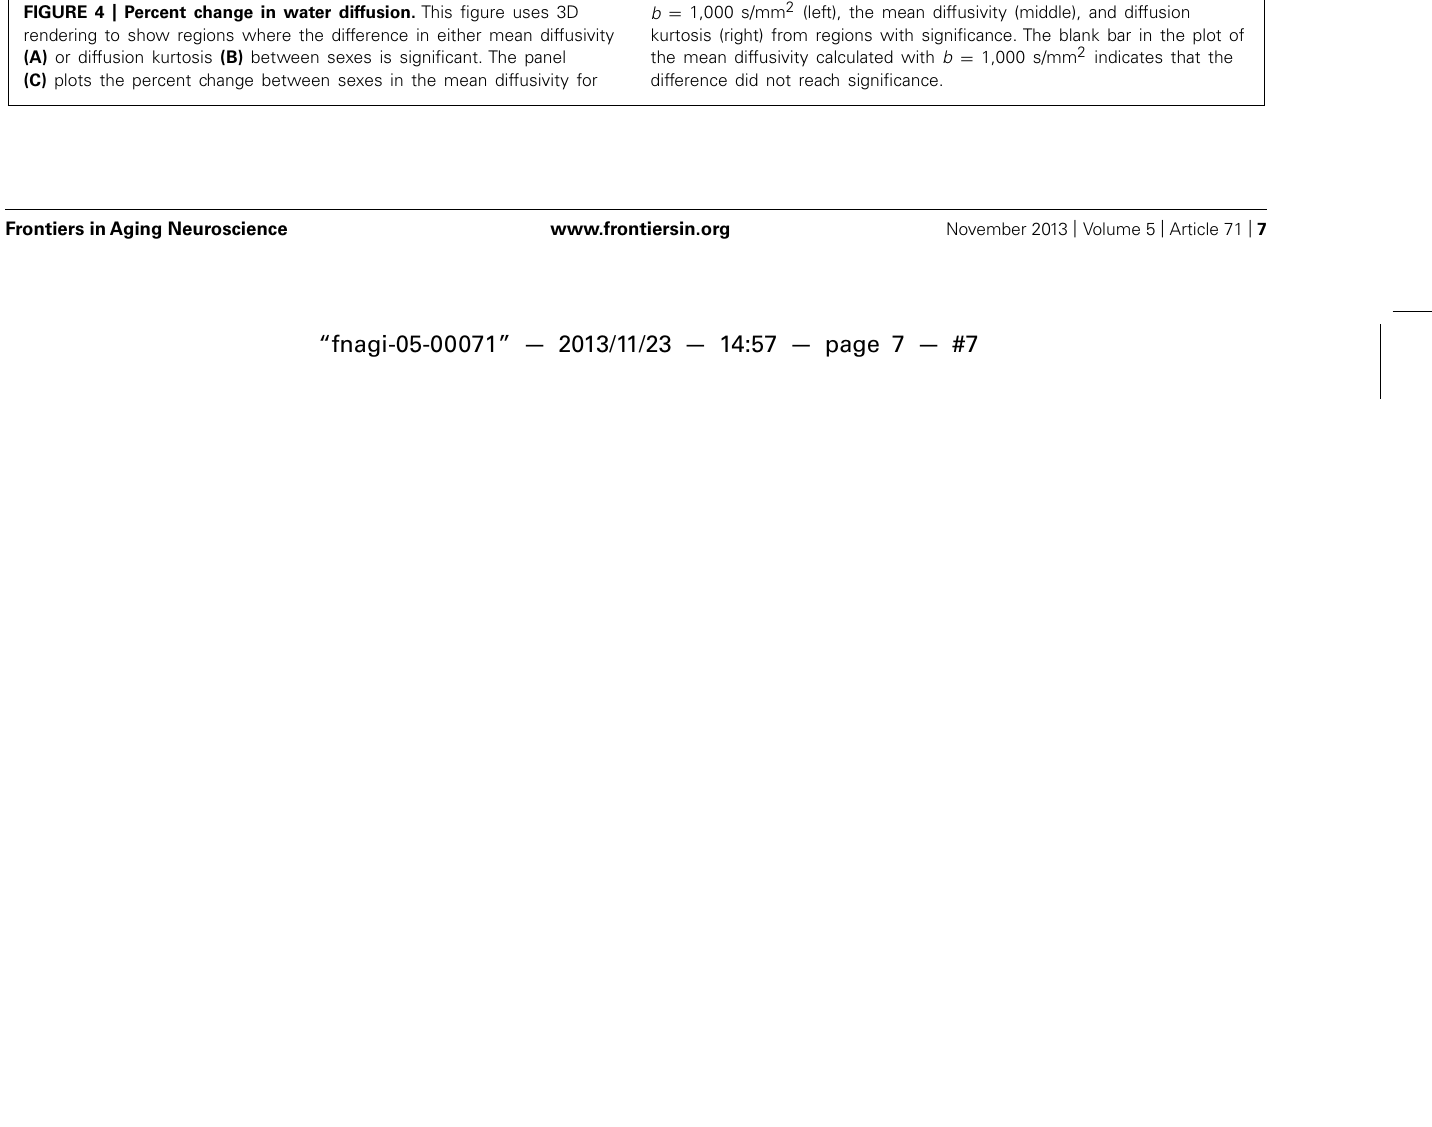
FIGURE 4 | Percent change in water diffusion. This figure uses 3D rendering to show regions where the difference in either mean diffusivity (A) or diffusion kurtosis (B) between sexes is significant. The panel (C) plots the percent change between sexes in the mean diffusivity for